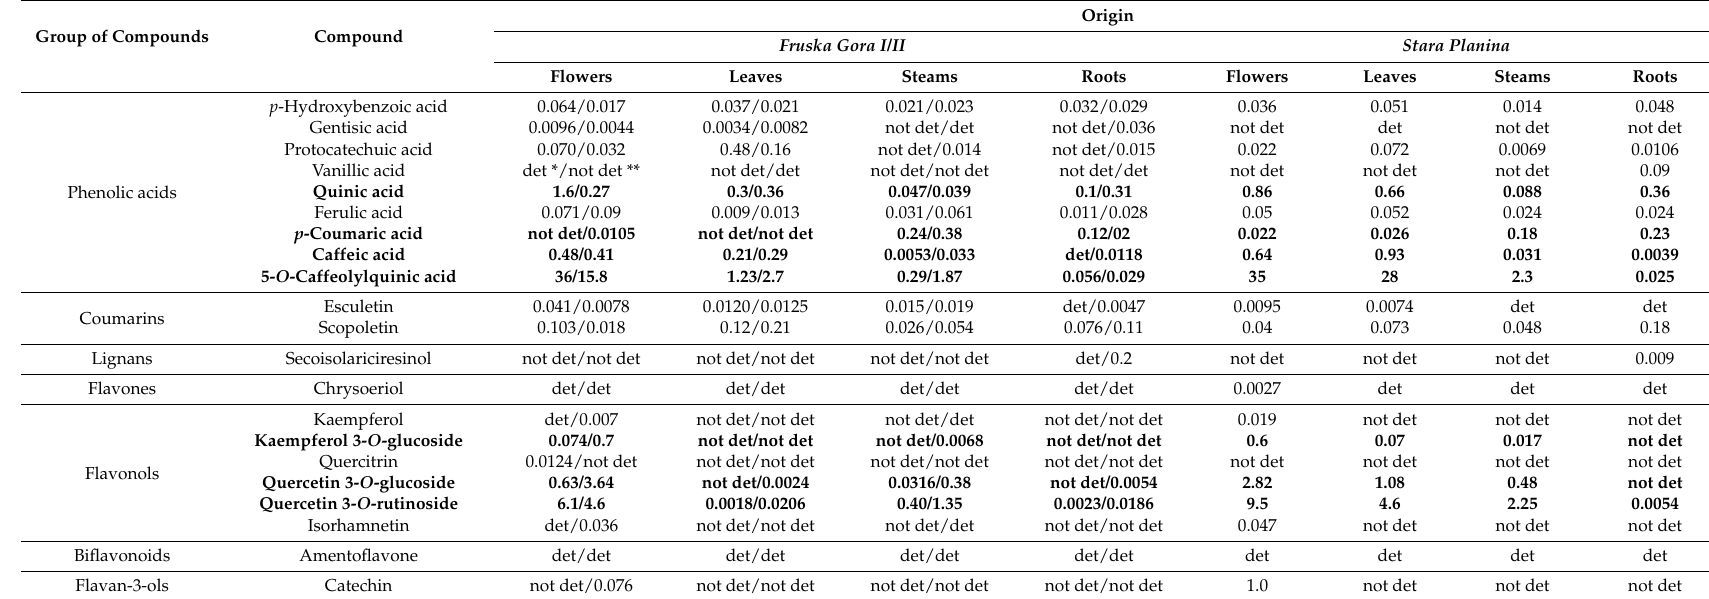
Table 3. The phenolic profiles in U. dioica extracts (mg per g of dry extract)